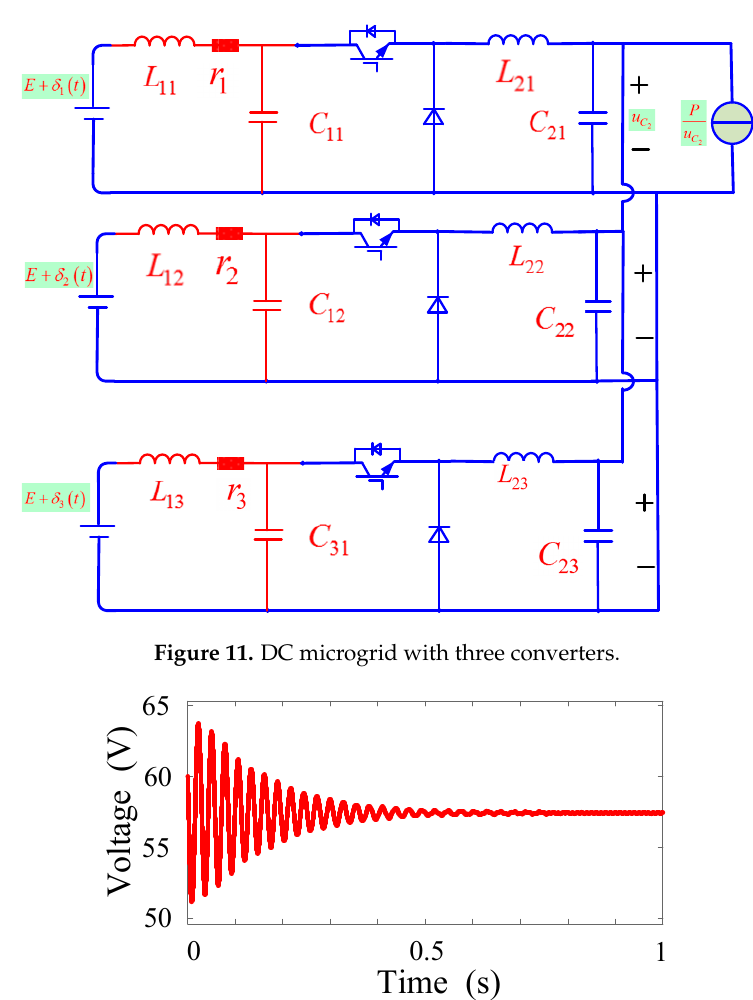
Figure 12. Output voltage of a DC microgrid with three identical converters.